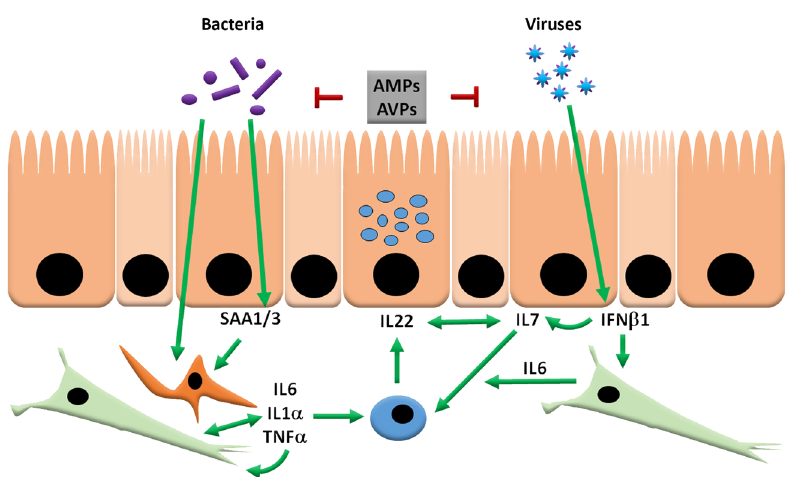
Fig. 7 Virus-mediated expression of IFN β 1 induces IL22 via IL7 and IL6 produced by IEC and fi broblasts, respectively. a IL22 reporter-activity of supernatants from EL4 cells stimulated with IL7 (indicated concentrations) and IL6 (10 ng/ml) for 48 h. b Il7 mRNA expression in 3D ileum-derived organoids, stimulated with indicated cytokines (10 ng/ml) for 24 h. c Il7 mRNA expression in 3D mouse organoids after IFN β 1 exposure for 24 h with indicated concentrations. d Immunostaining for IL7 (green), F-actin (magenta), or Nuclei (blue) in 2D ileum-derived organoids stimulated with IFN β 1 (20 ng/ml) or IL22 (2 ng/ml) for 24 h. Bars indicate 10 μ m. e IL7 protein expression in 2D mouse organoids after IFN β 1 exposure for 24 h with indicated concentrations. f Il7 mRNA expression in 3D human intestinal organoids, either differentiated (DIF) or undifferentiated (EXP), exposed to SARS-COV-2 for 60 h (GSE149312). g Il6 and I fi t2 mRNA expression in NIH3T3 fi broblasts stimulated with 20 ng/ml IFN β 1 for 24 h. h Microarray analysis of 2D and 3D mouse Ileum-derived organoids stimulated with IL22 (5 ng/ml) for 24h. Gene expressions are indicated as Fold Increase (IL22/untr) in Log2 values. i MHV-GFP (green) expression, 2 days after infection, in 2D mouse ileum-derived organoids untreated or treated with IL22 (5 ng/ml), F-actin (magenta), or nuclei (blue). Bars indicate 10 μ m. j Quanti fi cation of MHV-GFP positive cells in untreated and IL22 (5 ng/ml) treated 2D mouse ileum-derived organoids after 1 and 2 days of infection. All experiments were performed in triplicate with a minimum of three independent experiments. All data are shown as mean ± SD. For statistical analyses ( a – c and e ), Log2 transformed data were used in Welch and Brown – Forsythe tests followed by Dunnett ’ s T3 multiple comparisons test. For comparison in f , g , and j , we performed an unpaired t -test (two-tailed) with Welch ’ s correction on Log2 transformed data.